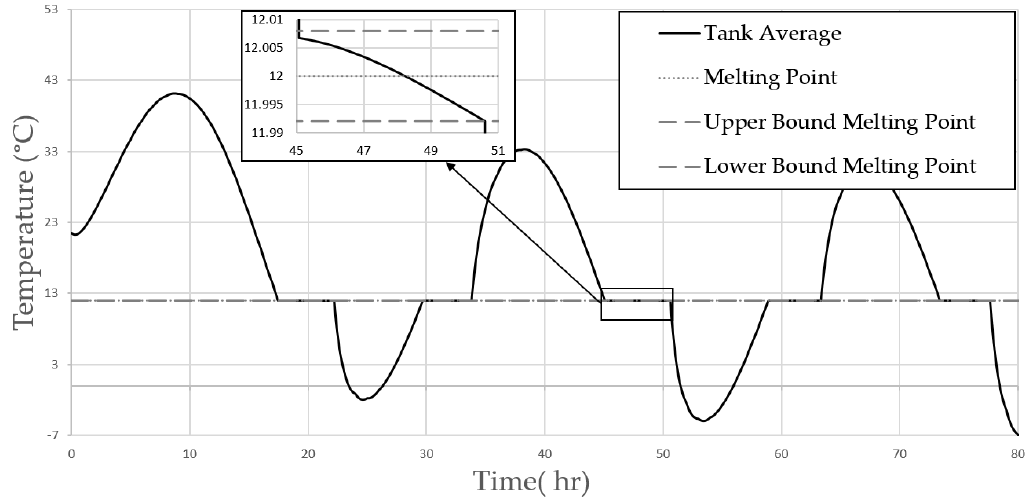
Figure 5. PCM Phase Change Operation.